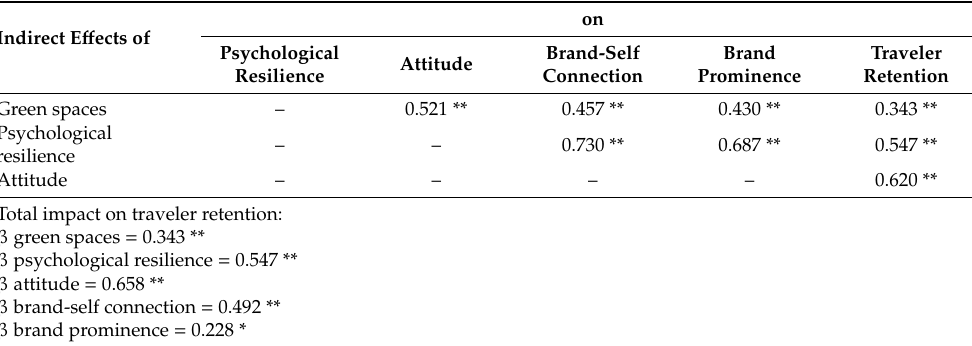
Table 4. Indirect impact and total impact assessment (n =